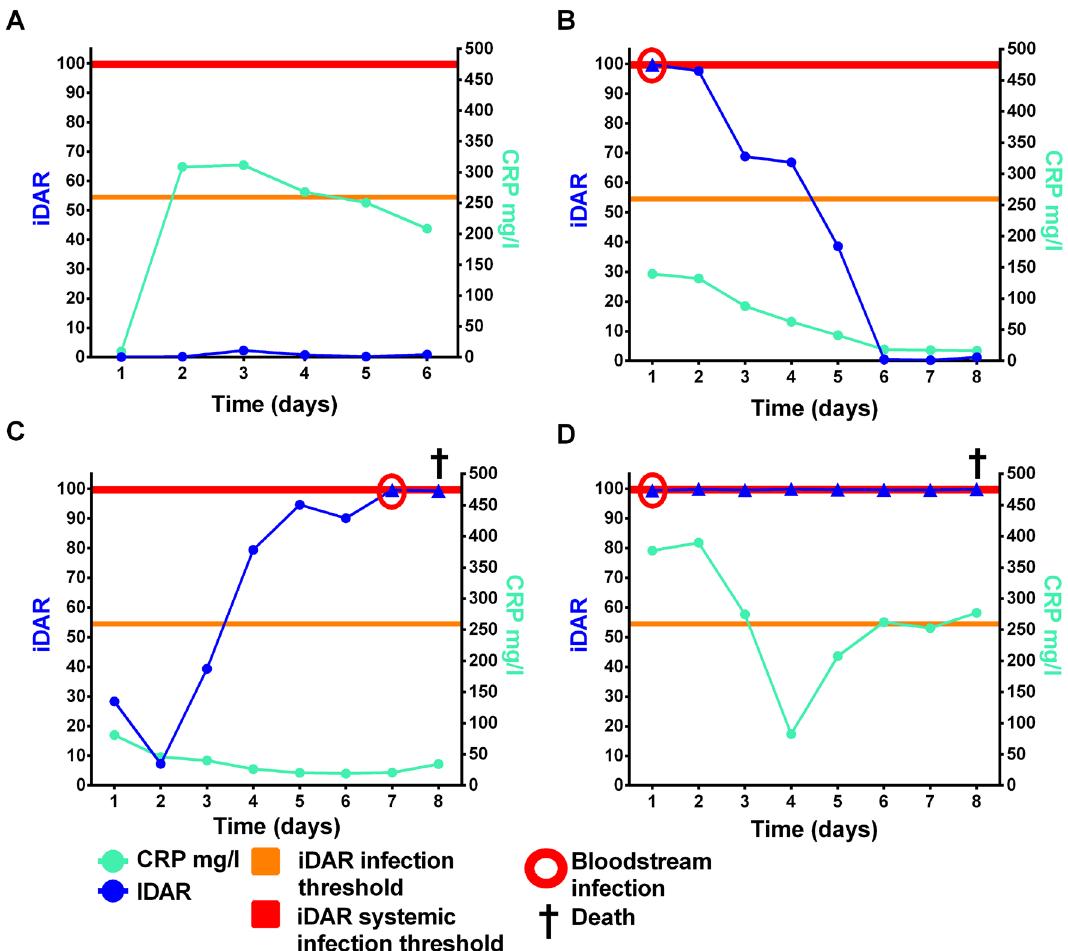
Figure 6. Representative plots of the iDAR score for ICU patients along with CRP comparison. Thresholds of iDAR for infection (orange line) and systemic infection (red line) are indicated by horizontal lines. The timing of positive hemoculture is indicated by a red circle. Patient ( A ): suffered a high velocity crash. Hospital stay was marked by an inflammatory syndrome, which resolved spontaneously without documented infection. iDAR remained low, while CRP levels increased to high concentrations (> 300 mg/l). Patient ( B ): was admitted to ICU for septic shock. Blood culture revealed the presence of Streptococcus anginosus immediately